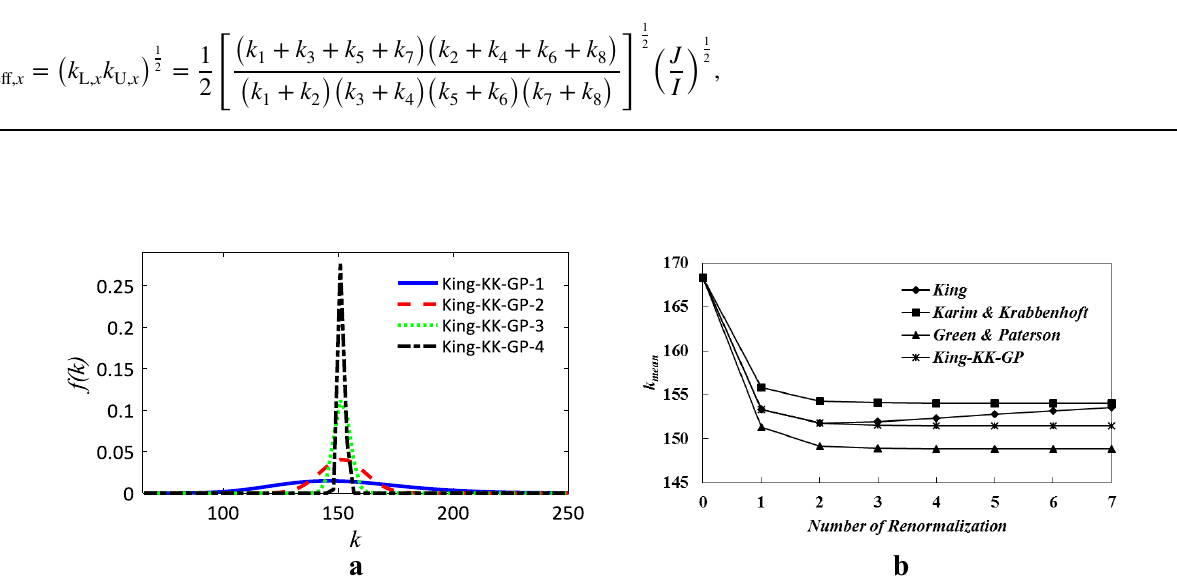
Fig. 3 a Distribution of permeability during renormalization processes for log-normal distribution, b comparison of the number of renormaliza- tion to the mean data from the four RGA scheme for log-normal